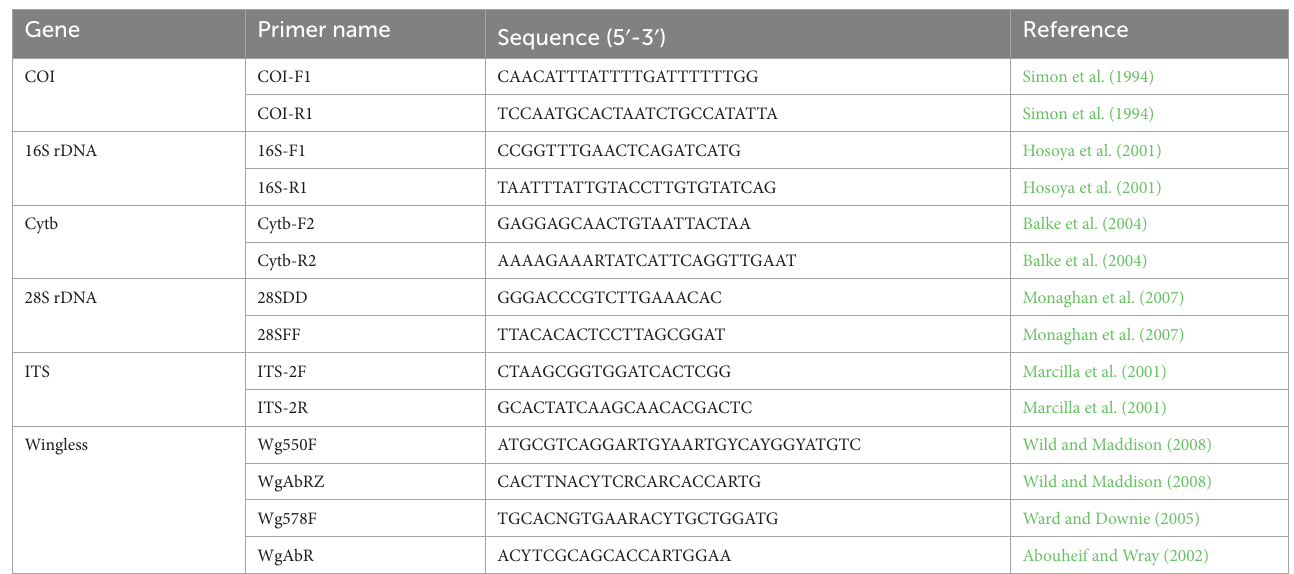
TABLE 1 Information on the primers used in this